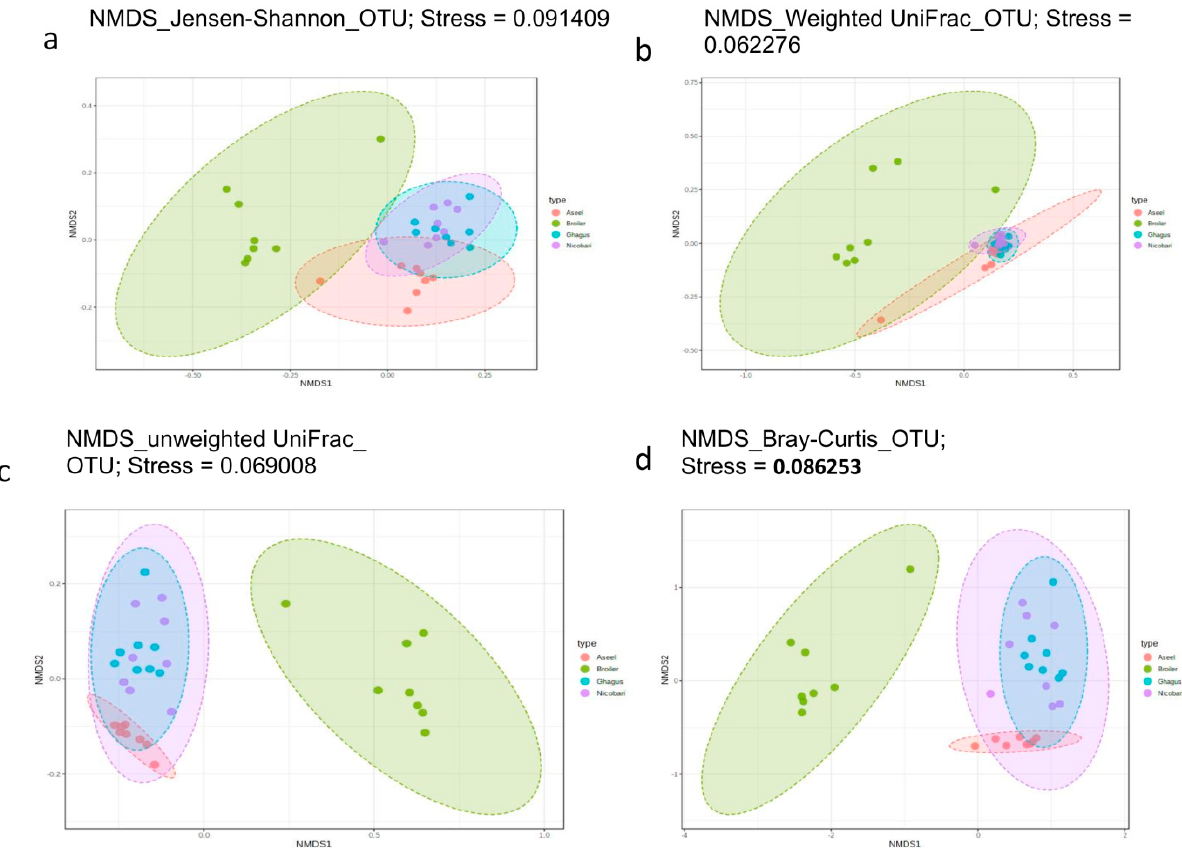
Figure 3. Beta diversity among breeds or lines. Beta diversity plots visualized using nonmetric multidimensional scaling based ordination at OTU level for different beta diversity metrics ( a ) Jensen-Shannon, ( b ) weighted UniFrac, ( c ) Un-weighted UniFrac, ( d ) Bray-Curtis. A stress value of less than 0.1 represents a high-quality ordination.